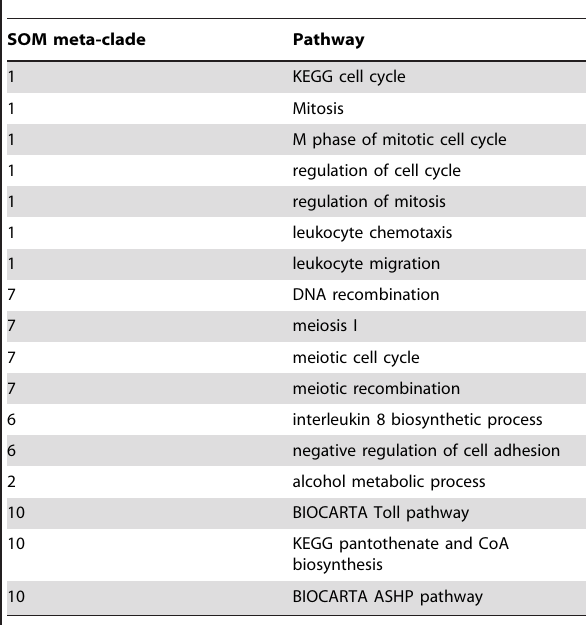
Table 3. Convergent pathways where the SOM meta-clades overlap with SOM clades found to be most negatively correlated with the ASPL-TFE3 fusion transcript